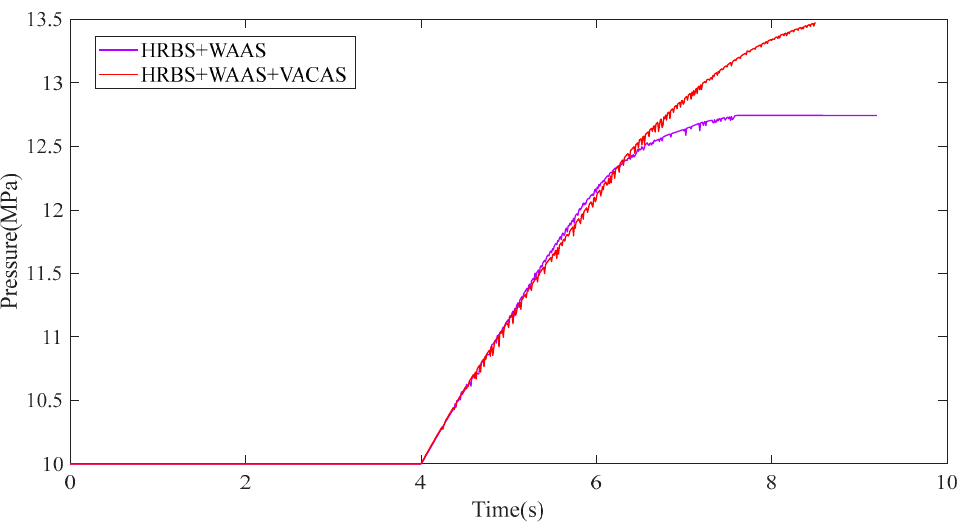
Figure 17. The variation curve of the sideslip angle.